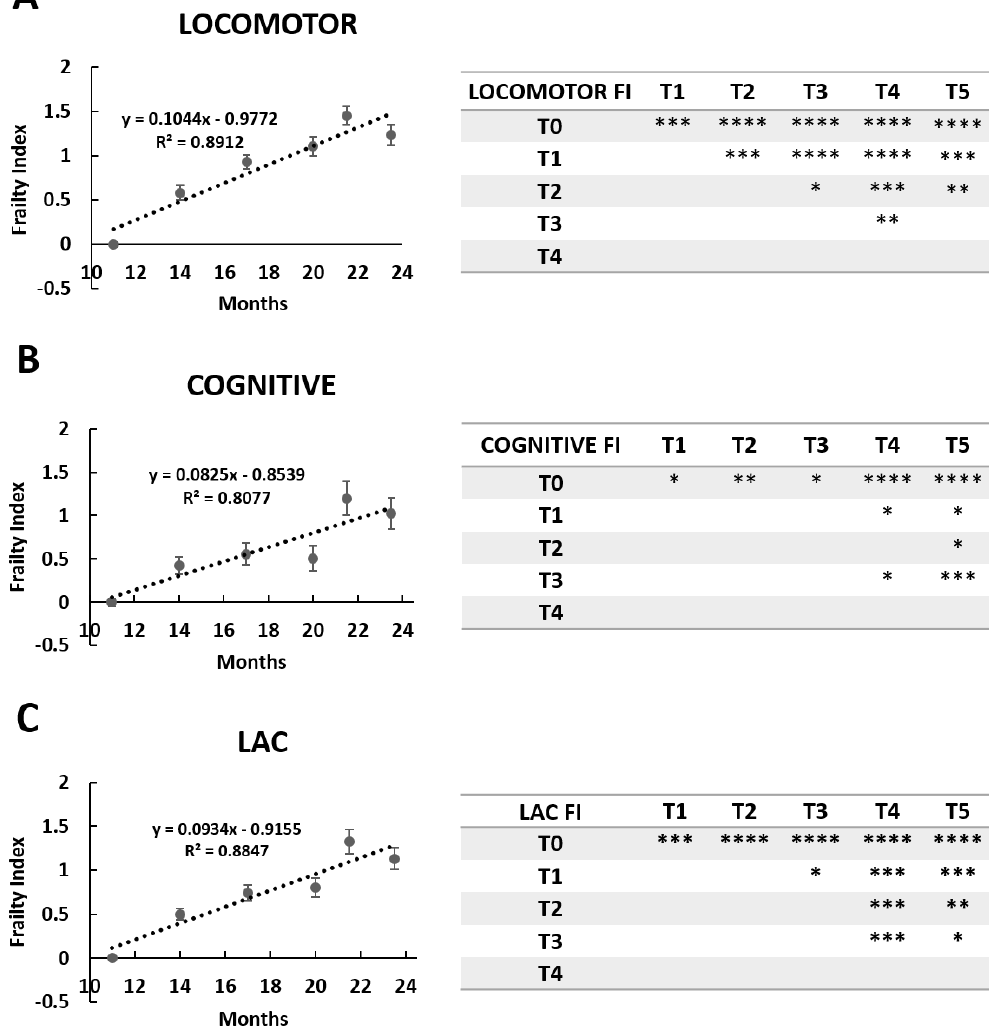
Figure 3. Locomotor, cognitive, and LAC (locomotor and cognitive) decline during physiological aging in mice. Locomotor (panel ( A )), cognitive (panel ( B )), and LAC (panel ( C )) Frailty Index during physiological aging in mice. Linear regressions of experimental points and statistical results were reported. p < 0.05 (*), p < 0.01 (**), p < 0.001 (***), p < 0.0001.